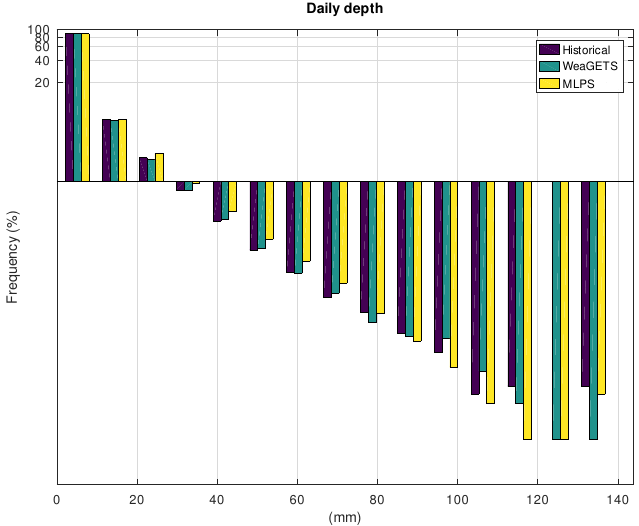
Figure 4. Histogram of the daily synthetic time series (WeaGETS and MLPS) and historical values of the Hohenpeissenberg weather station.